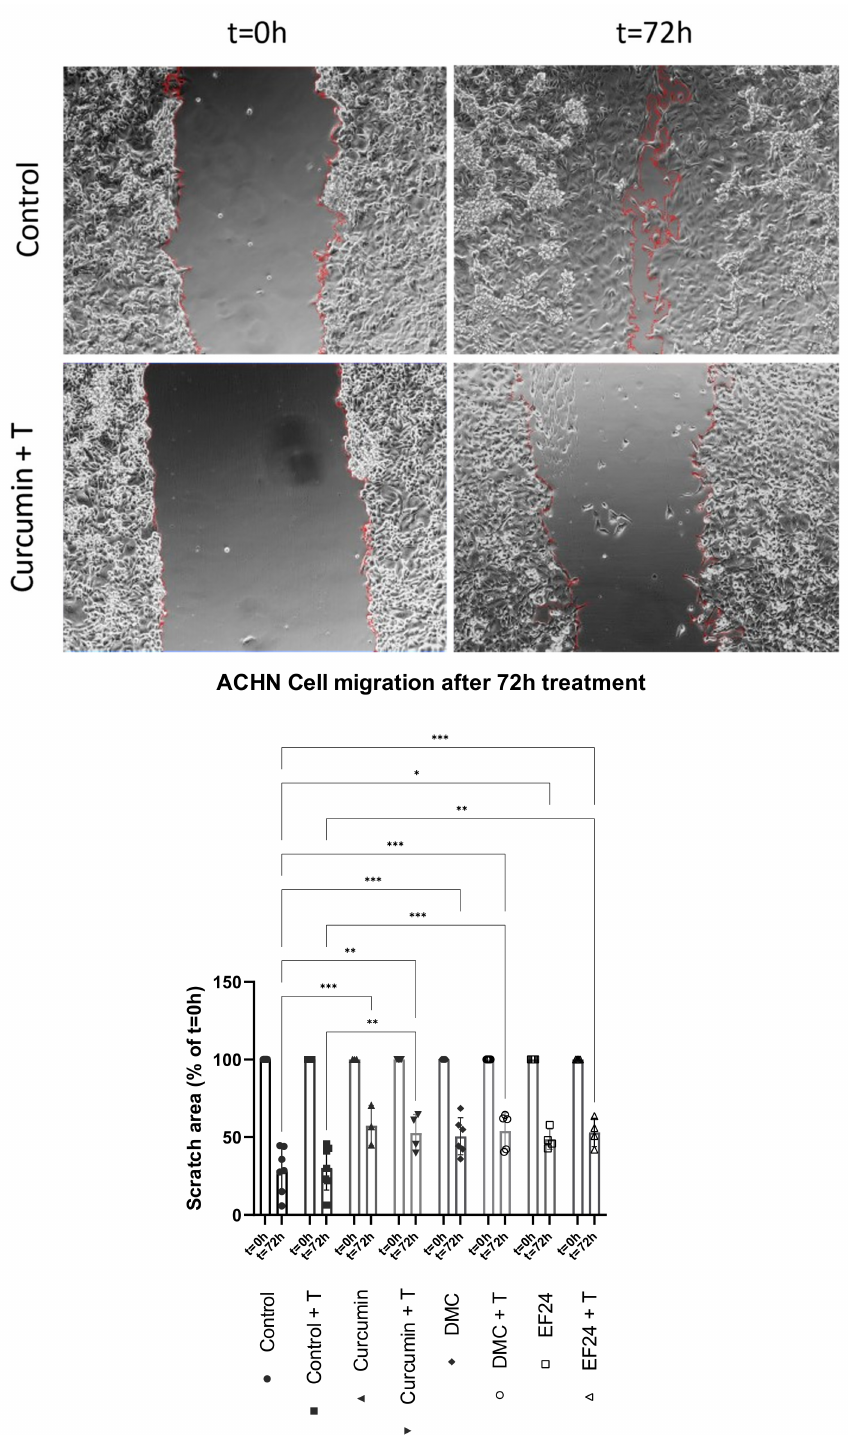
Figure 6. ACHN cell migration was reduced following 72 h treatment with DMC + TRAIL and EF24 + TRAIL as previously shown [18]. In this study, we show that 72 h treatment with curcumin and curcumin + TRAIL also led to a significant decrease in scratch area (52.66% compared to 28.78% in the control). Representative pictures of control and curcumin + TRAIL are shown. Red lines indicate the limits of the scratch area. ( n = 4). * p < 0.05, ** p < 0.01, *** p <